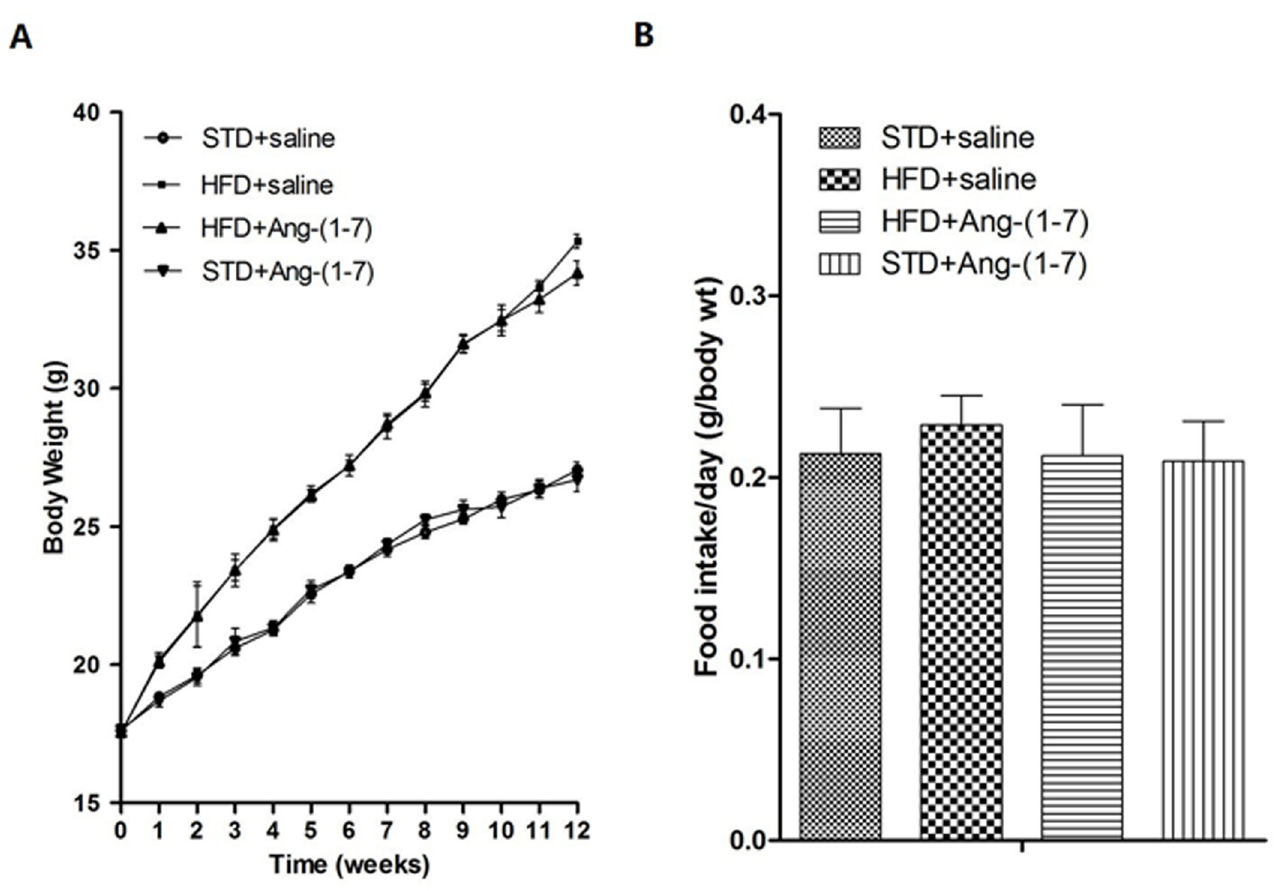
Fig 1. Changes in body weight and food intake. A: Average weekly body weights of male C57BL/6 mice in all groups. Values are expressed as means ± SD (n = 10). B: Food intake was measured to obtain food efficiency. Values are expressed as means ± SD (n = 12).